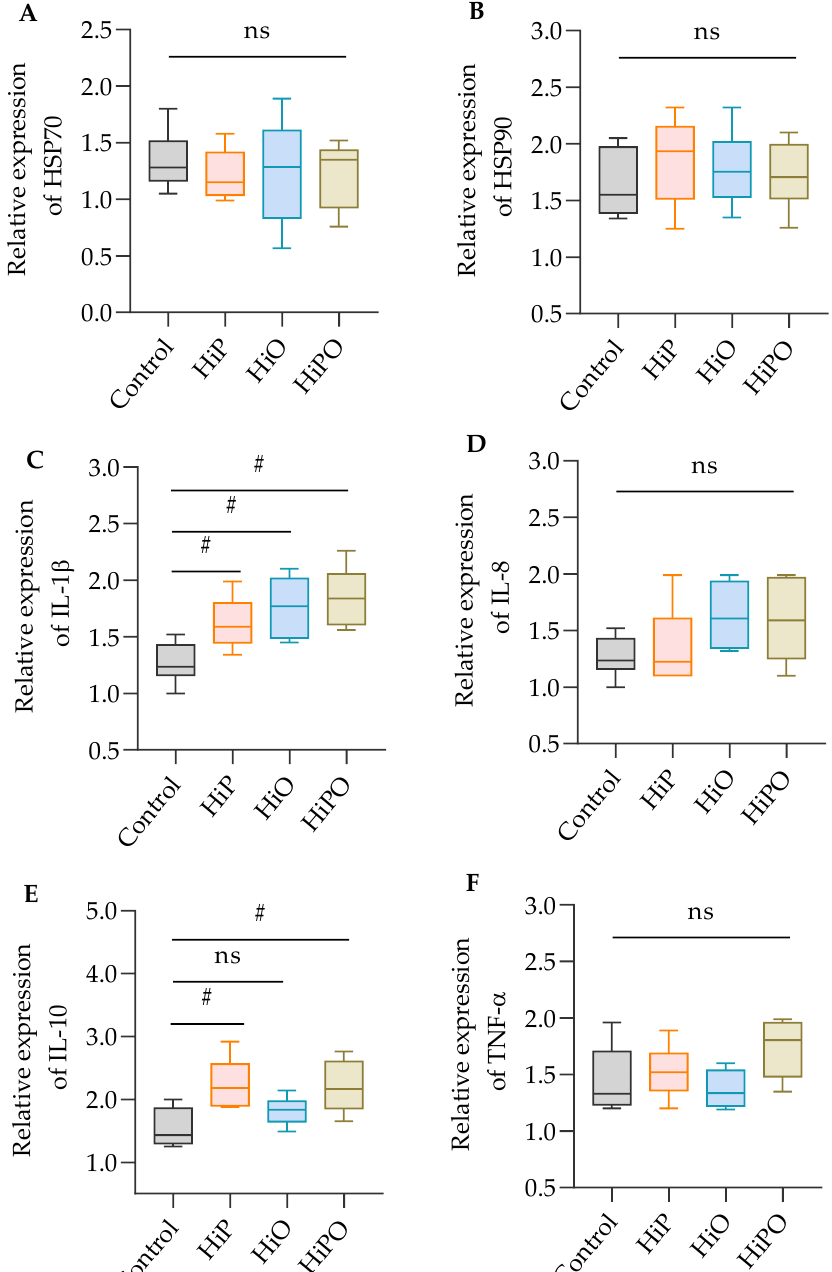
Figure 3. Relative expression of heat shock proteins, HSP70 and HSP90 ( A , B ) in the liver and immune- responsive genes IL-1 β , IL-8, IL-10, and TNF- α ( C – F ) in the distal intestine of juvenile barramundi fed BSF larvae protein and oil as FM protein and oil replacement diets. Data were expressed as mean ± SE, n = 6. Bar indicates significant difference among the experimental treatments (one-way ANOVA; Tukey post-hoc test; ns, not significant at p > 0.05; #, significant at p <